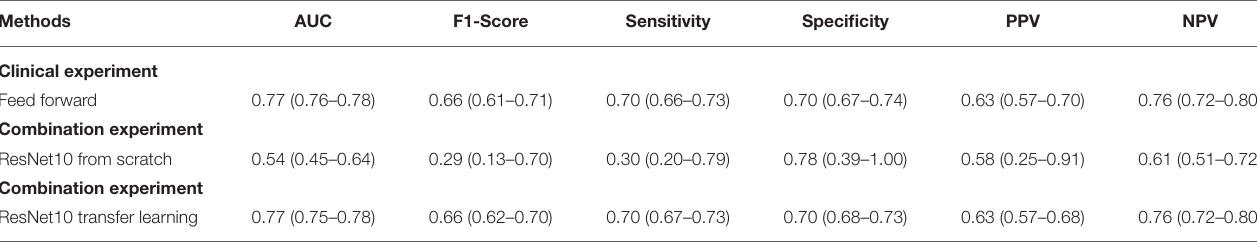
TABLE 4 | Results of all experiments from the deep learning approaches for predicting the good functional outcome [modified Rankin Scale (mRS) ≤ 2].